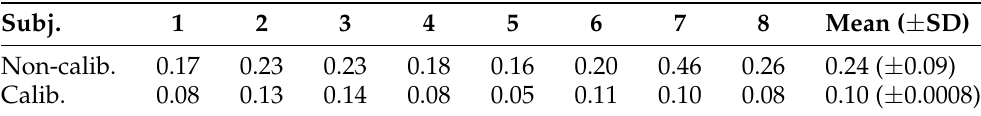
Table 10. Mean absolute error in amplitude (cm). First row: non-calibrated MMS vs. RPM. Second row: calibrated MMS vs. baseline drift corrected